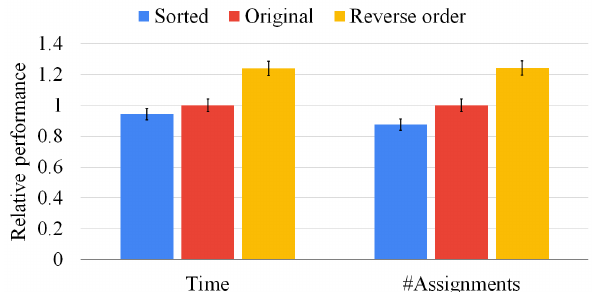
Figure 9. Our sorting heuristic against the state-of-the-art order and the reverse one on graph pairs of the same size. We report the mean resolution time (on the left-hand side) and the average number of vertex pairs checked (on the right-hand side) normalized with respect to the original method. The standard deviation of the ten runs is reported on top of each bar.